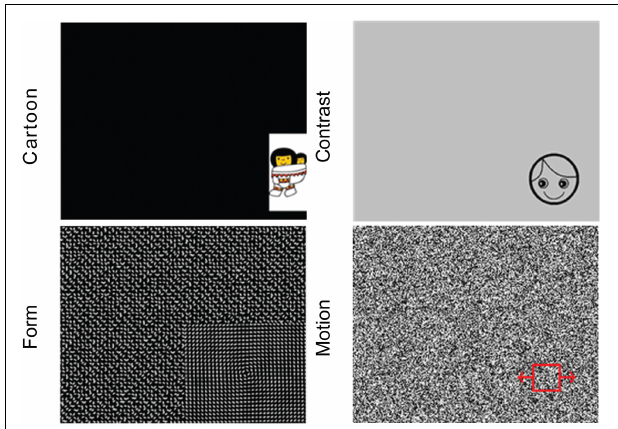
FIGURE 1 | The four stimulus types with various visual content, from left to right and up to down: Cartoon, Contrast, Form, and